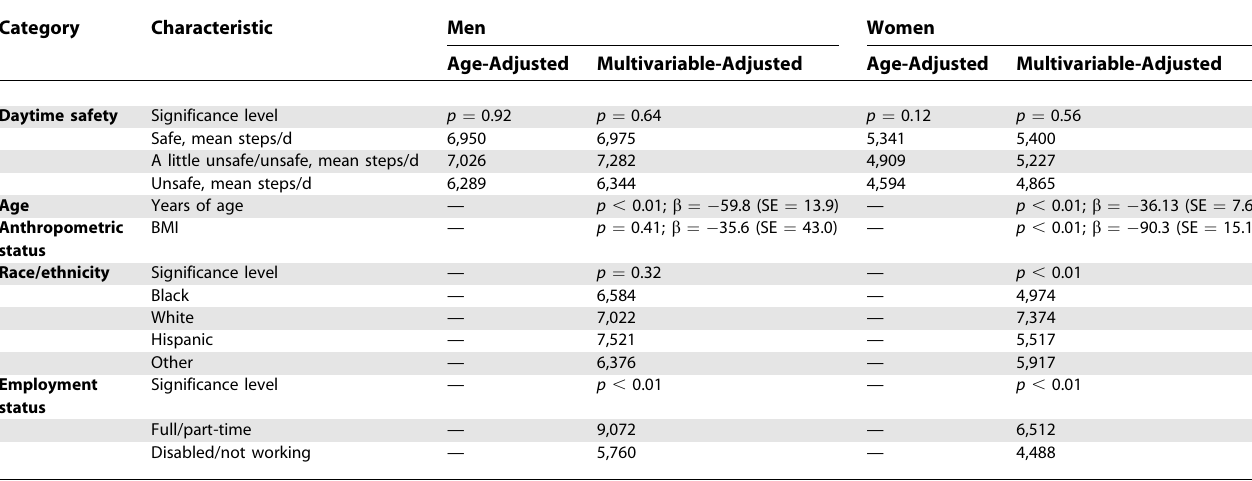
Table 3. Perceived Daytime Neighborhood Safety and Steps Per Day